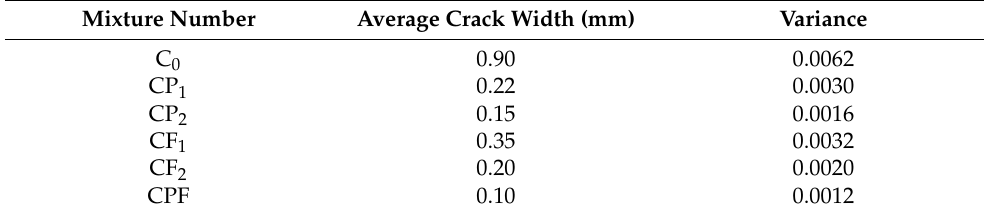
Table 6. Initial crack widths for different